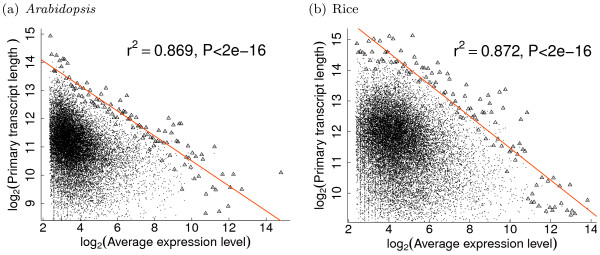
Extreme values of transcript lengths for plant genes scale as power-laws of expression levels. In each graph, each point represents one gene in the whole dataset, whereas triangles denote the data subset used to fit the linear line. Axes are all on the logarithmic scale. Expression data were taken from MPSS experiments [19].